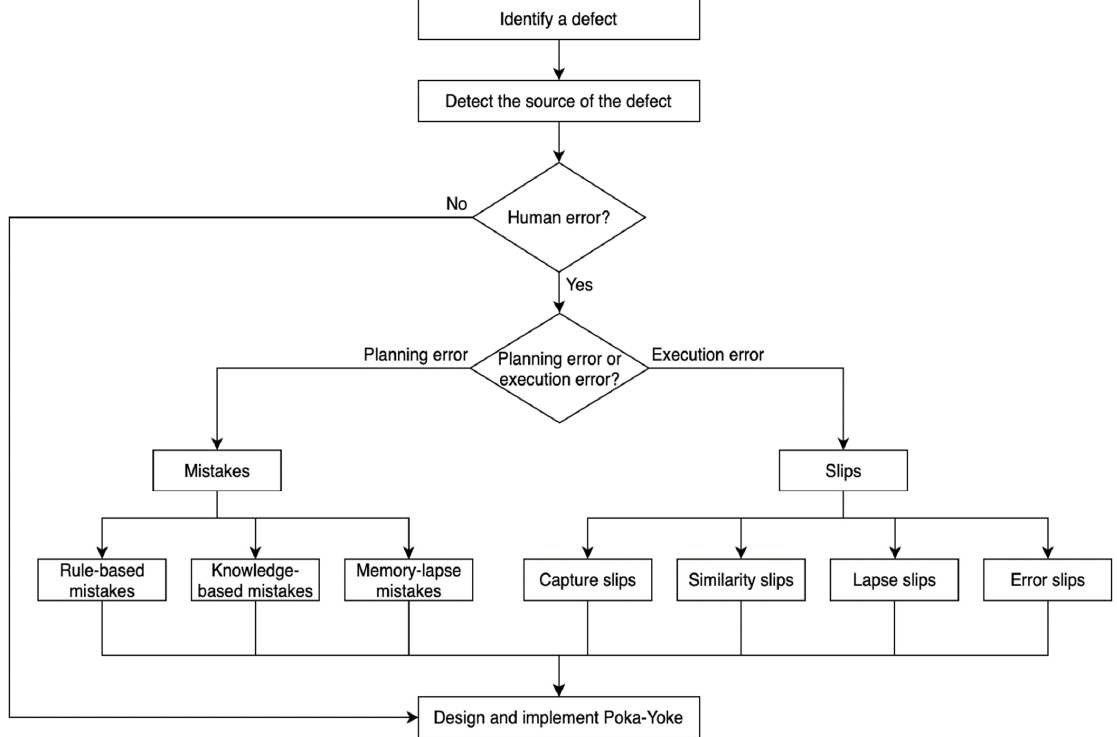
Figure 1. Framework designed to help identify and manage the root cause of aircraft snags (developed based on the work of Zhang [36] and Norman [26] ).